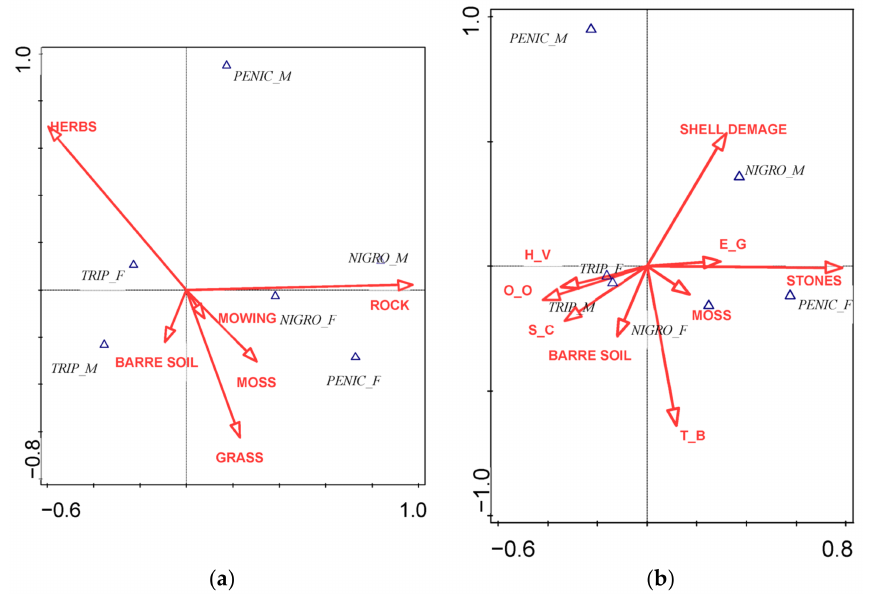
Figure 3. Influence of environmental conditions within the wider environment (1 × 1 m): ( a ) of immediate surroundings ( b ) of shells. H_V = Height of vegetation, O_O = Orifice orientation of shells, S_C = Shell cleanliness, T_B = Thickness of the shell bands, E_G = Exposure below the